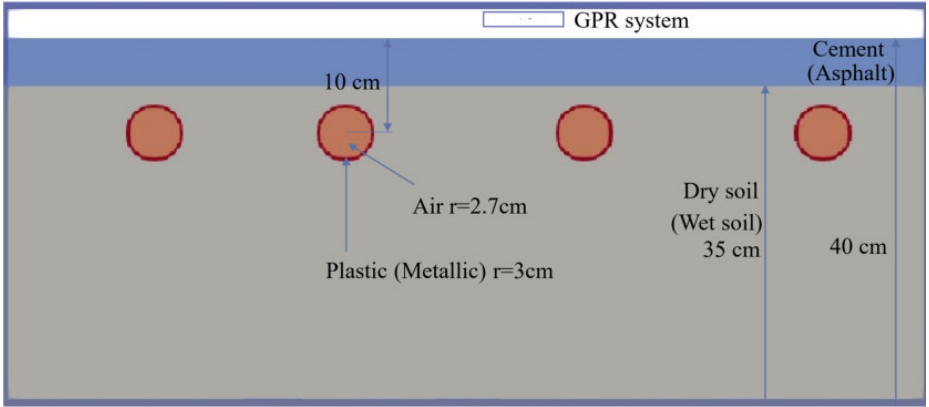
Figure 5. Simulation